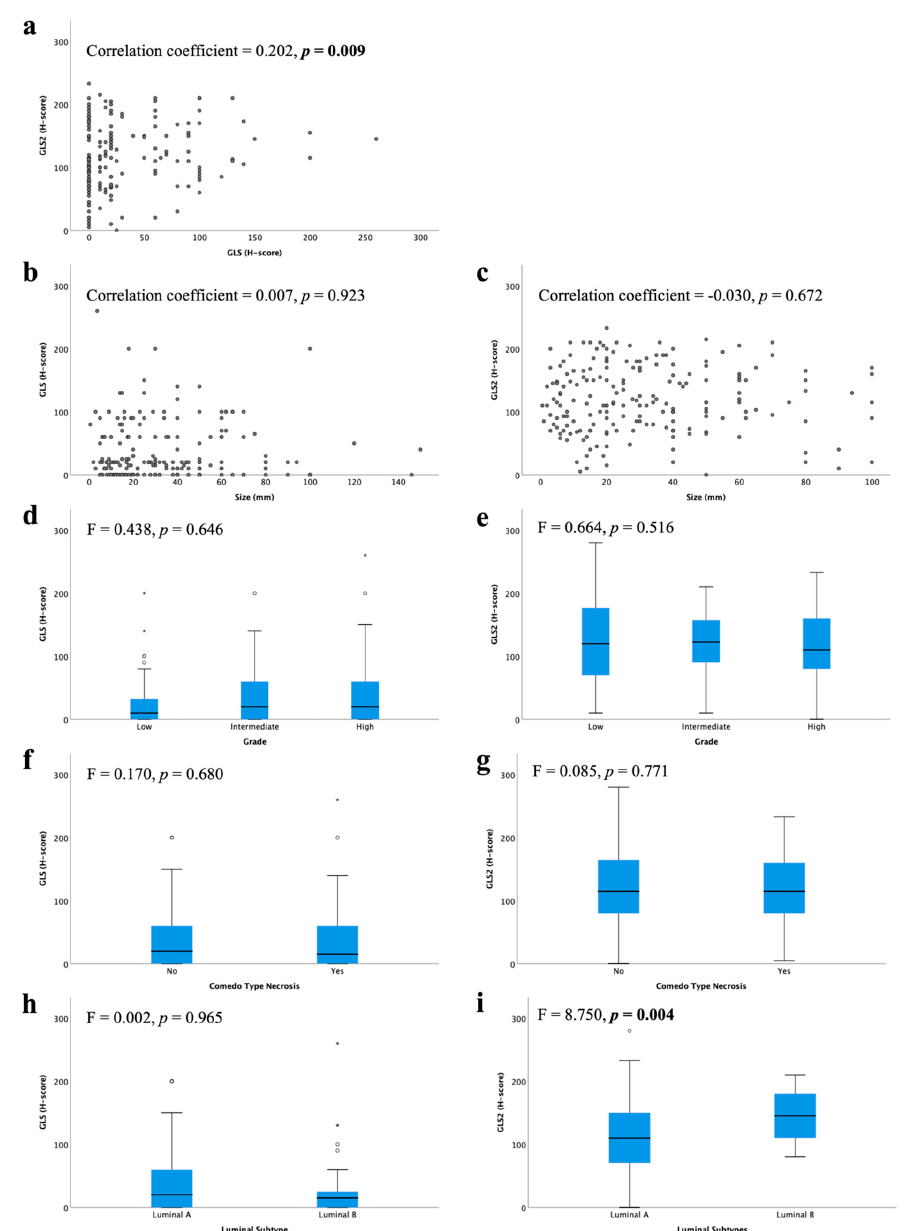
Figure 2. Glutaminase protein expression and its association with clinicopathological parameters and molecular subtypes in ER +/HER2- DCIS: ( a ) GLS and GLS2, GLS and ( b ) tumour size, ( d ) tumour grade , ( f ) comedo type necrosis, ( h ) luminal subtypes; GLS2 and ( c ) tumour size, ( e ) tumour grade, ( g ) comedo type necrosis, ( i ) luminal subtypes using Kruskal– Wallis test. Statistically significant p values are in bold .